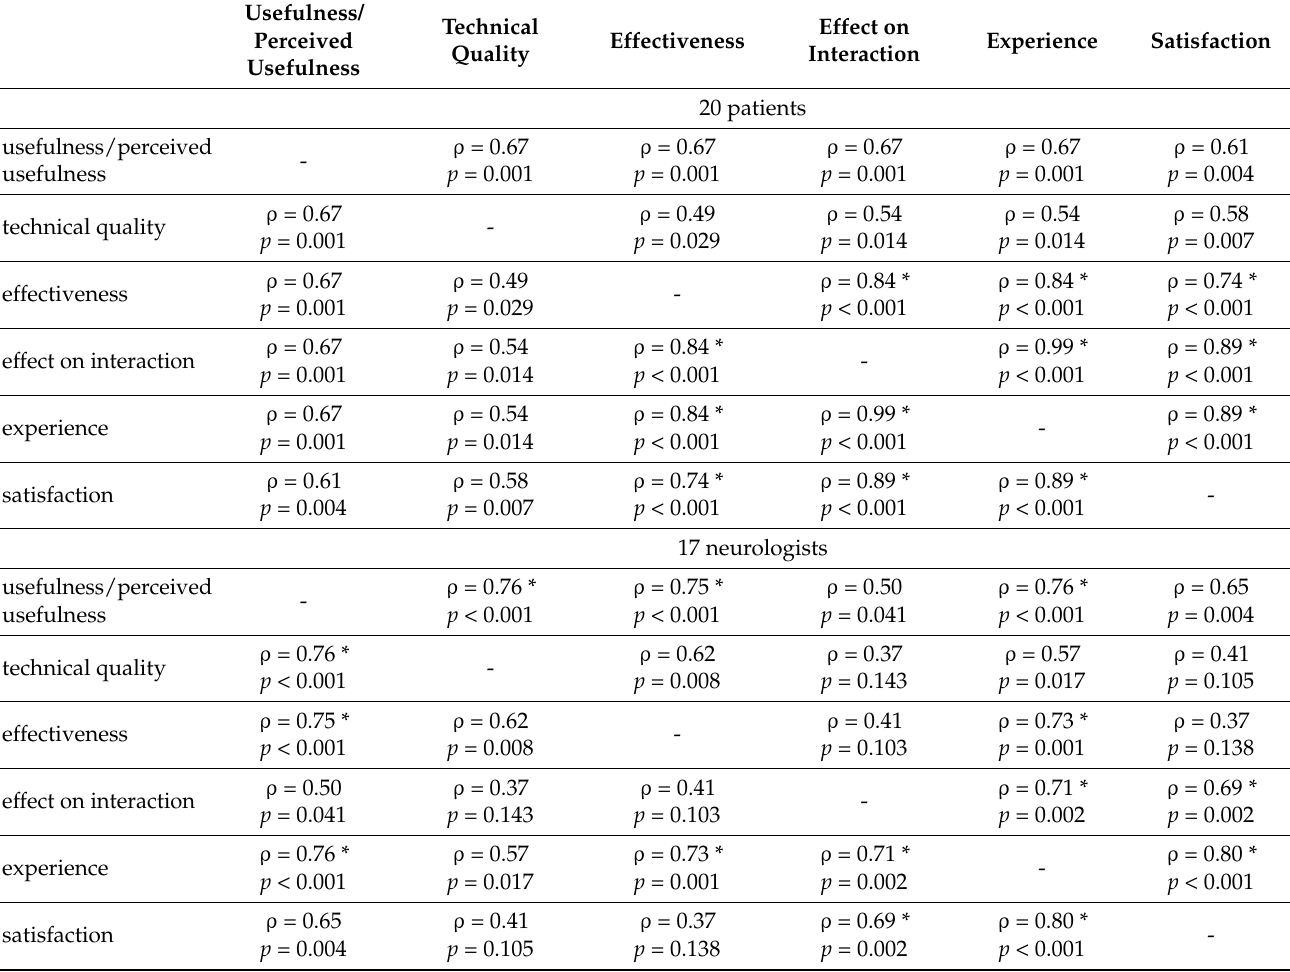
Table 4. Correlations between constructs for PD patients and